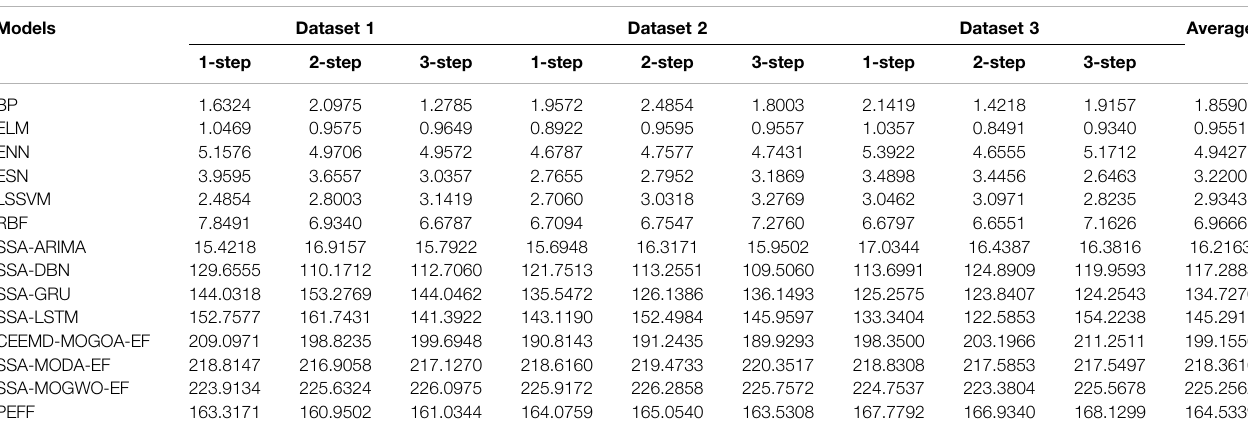
TABLE 10 | Run time of each